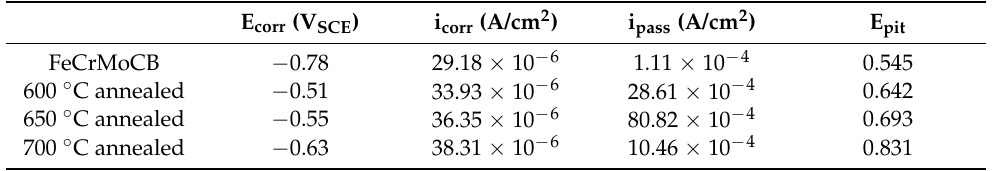
Figure 4. Polarization curves of Fe-based amorphous alloy coatings carried out with different annealing temperature. Table 4. Corrosion potential and corrosion current density measured after annealing of Fe-based amorphous alloy coatings.